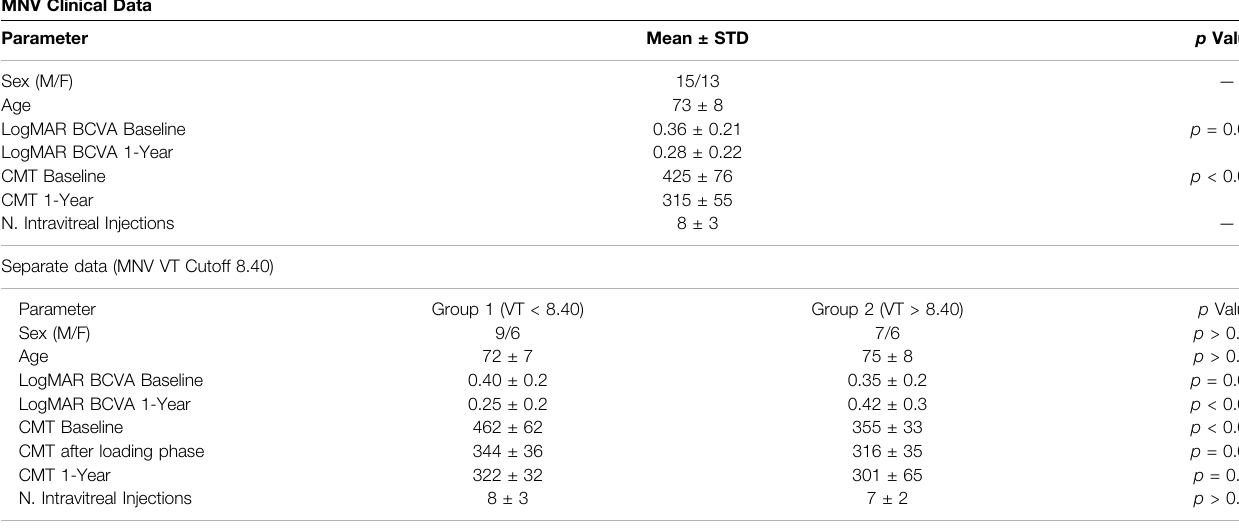
TABLE 1 | MNV clinical data. The following abbreviations are used: best corrected visual acuity (BCVA), central macular thickness (CMT), vessel tortuosity (VT). MNV Clinical Data